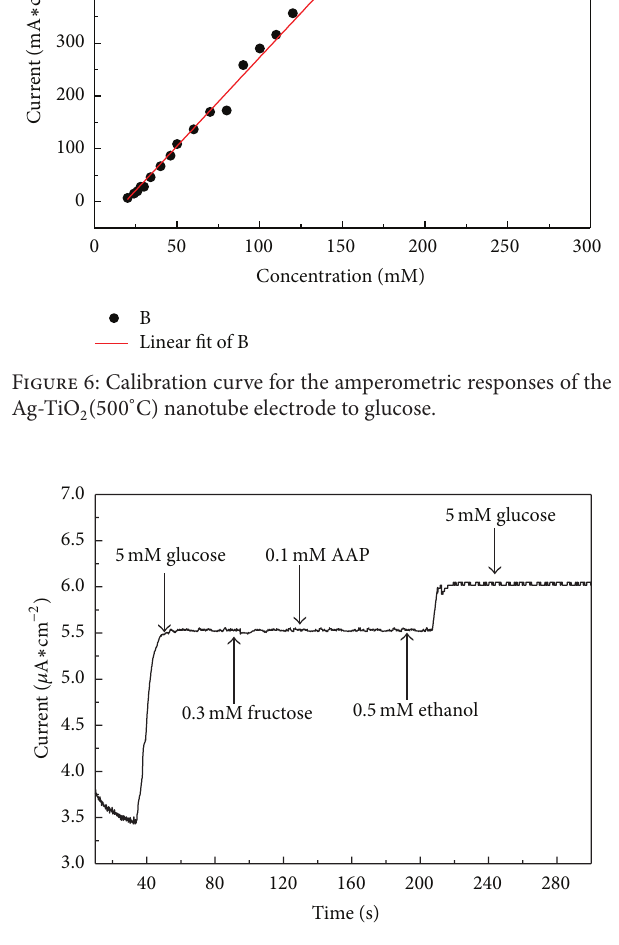
Figure 7: The influence of electroactive compounds (ethanol, fructose, and AAP) on the response of 5.0 mM